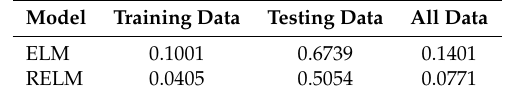
Table 4. The standard deviations of the RMSE measure for the ELM and RELM